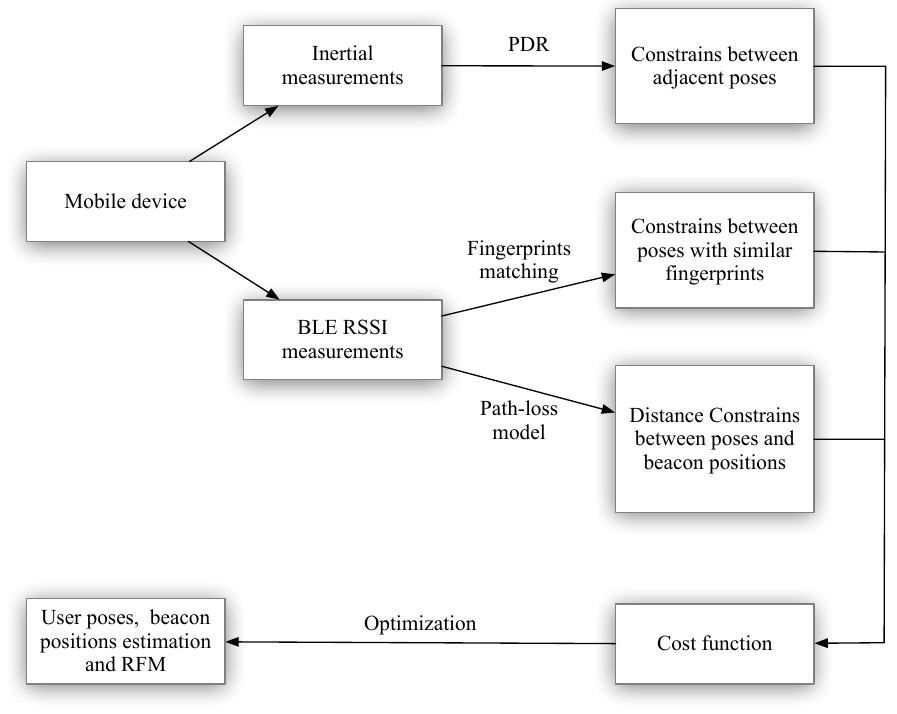
Figure 1. The overall data processing flow of the proposed